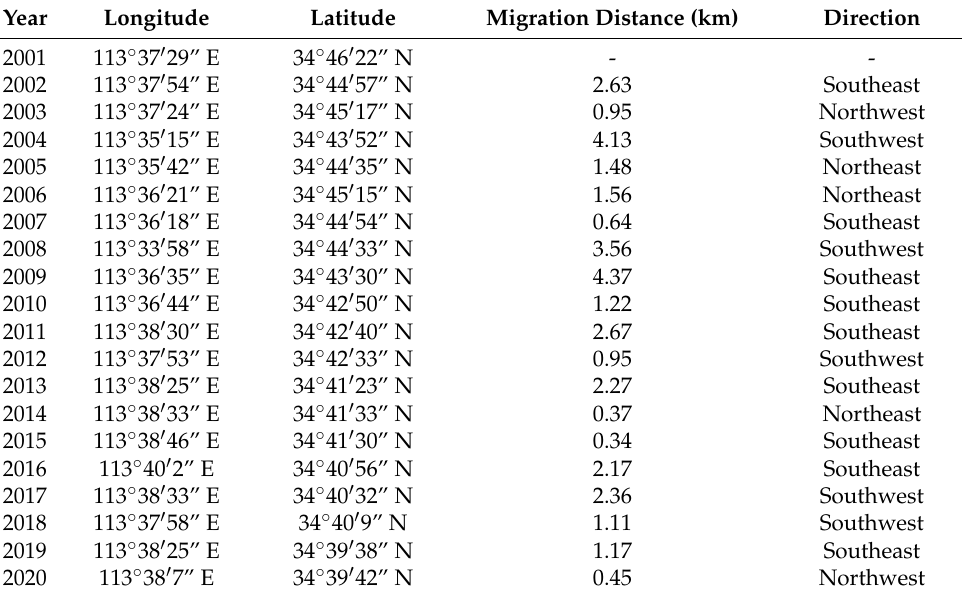
Table 4. Zhengzhou information from 2001–2020 on the parameters of the economic center.